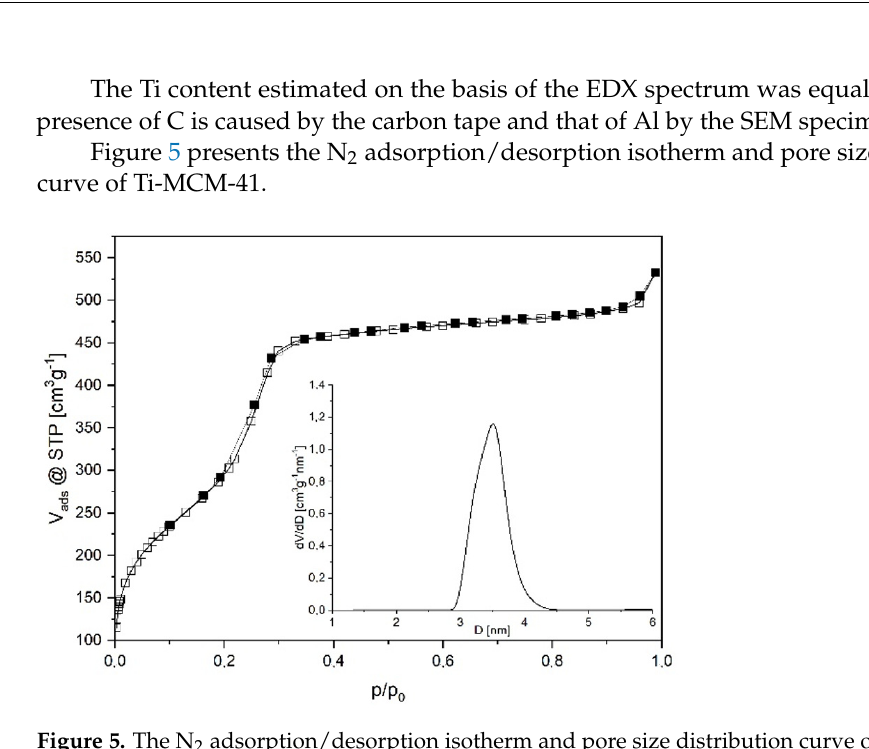
Figure 4. EDX spectrum of Ti-MCM-41.